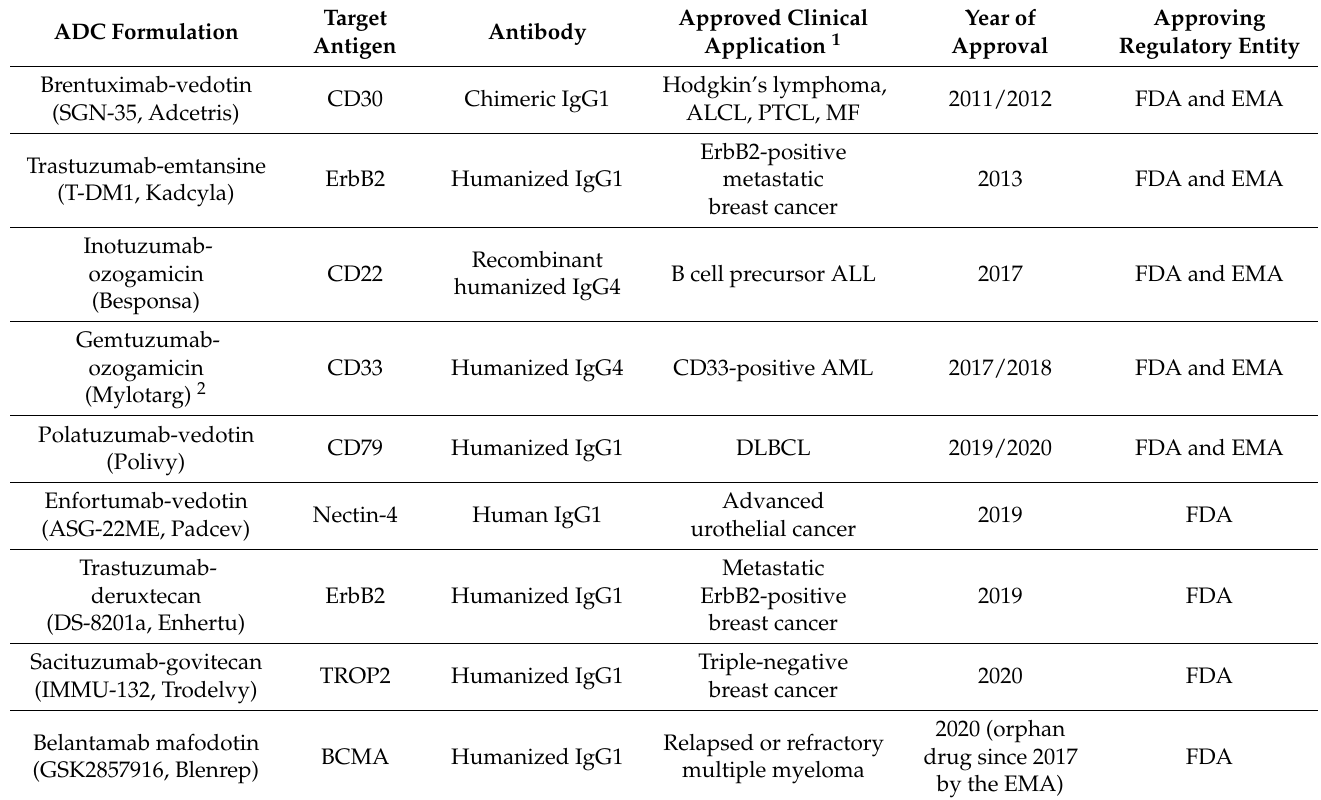
Table 1. Panel of antibody-drug conjugates (ADCs) approved by the Food and Drug Administration (FDA) and the European Medicines Agency